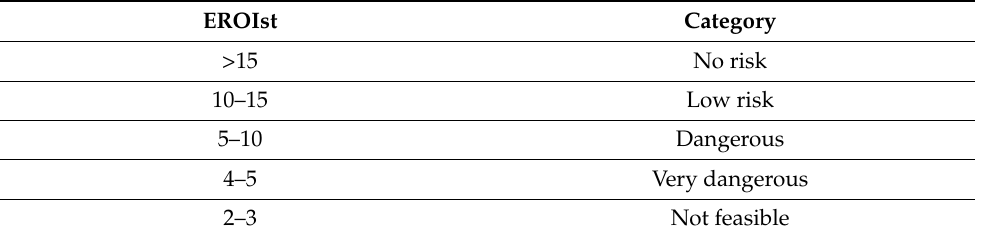
Table 4. EROI for renewable energy categories (source: authors, amended from Capell á n-P é rez et al., 2019